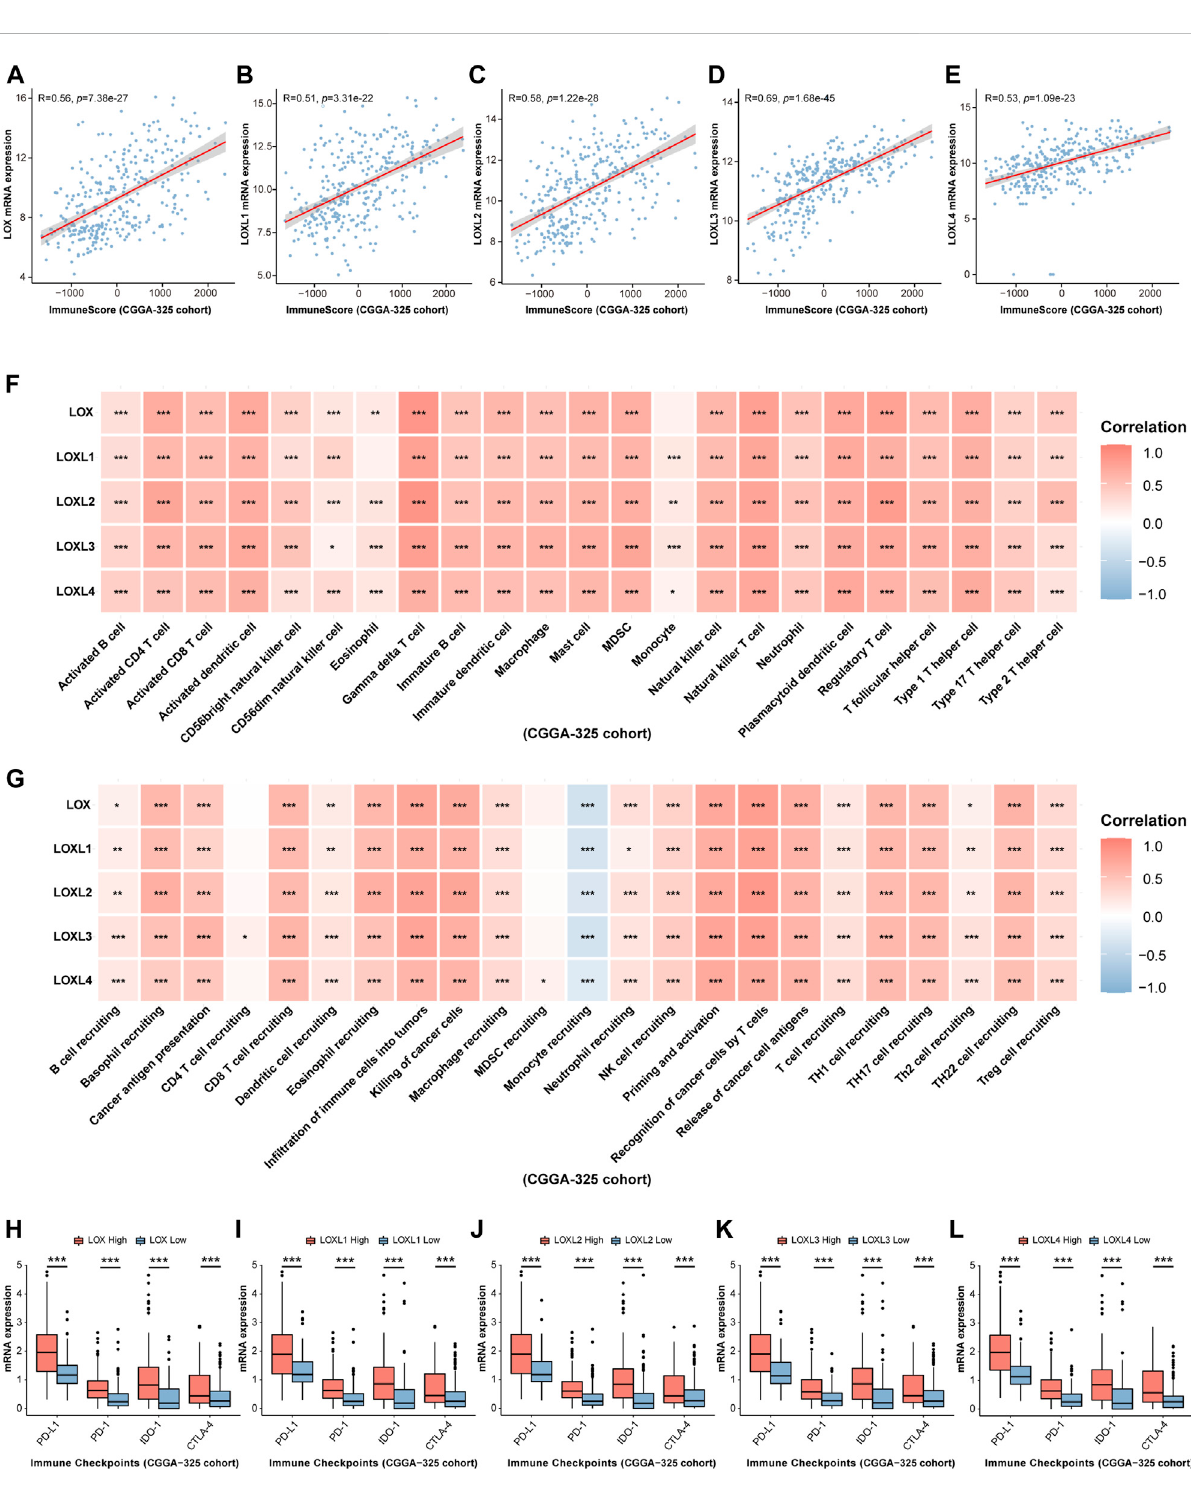
FIGURE 8 Analysis of the relationship between LOXs expressions and immune response in glioma in CGGA-325 cohort. (A – E) Correlation between differential LOXs expressions and immune score in glioma in CGGA-325; (F,G) relationship between differential expressions of LOXs and immune in fi ltration score orcancer immunitycyclesingliomainCGGA-325; (H – L) relationship betweendistinct LOXs expressions andimmunecheckpoints (including PD-L1, PD-1, IDO-1, and CTLA-4) in glioma in